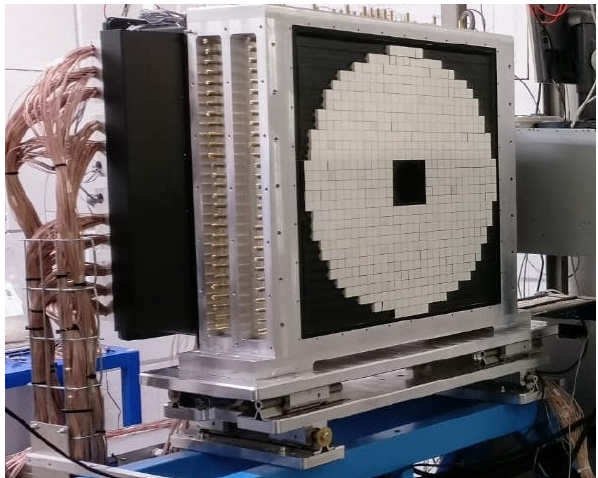
Figure 2. The PADME Electromagnetic